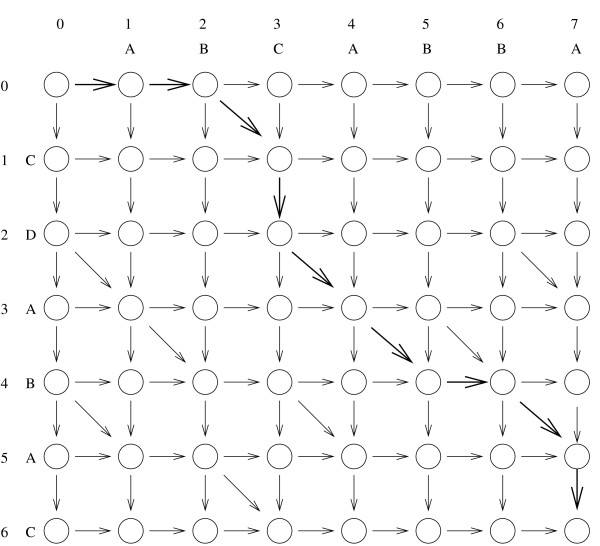
an edit graph. An edit graph for the strings X = CDABAC and Y = ABCABBA. It naturally corresponds to a DP matrix. The bold path from (0, 0) to (6, 7) gives an edit script from which we can recover the LCS between X and Y.